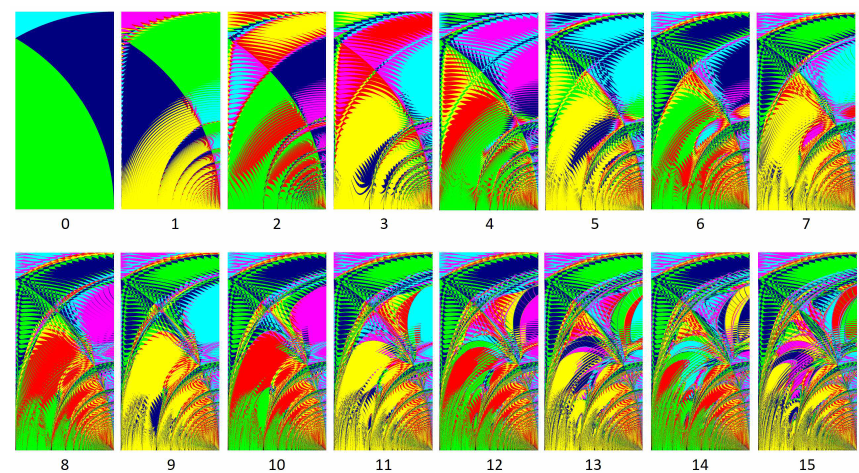
Fig. 3. Sensitivity to initial conditions. The initial (0), and the next 15 symbols in the sequences for Method D are presented. Different colors correspond to different symbols. Black color corresponds to